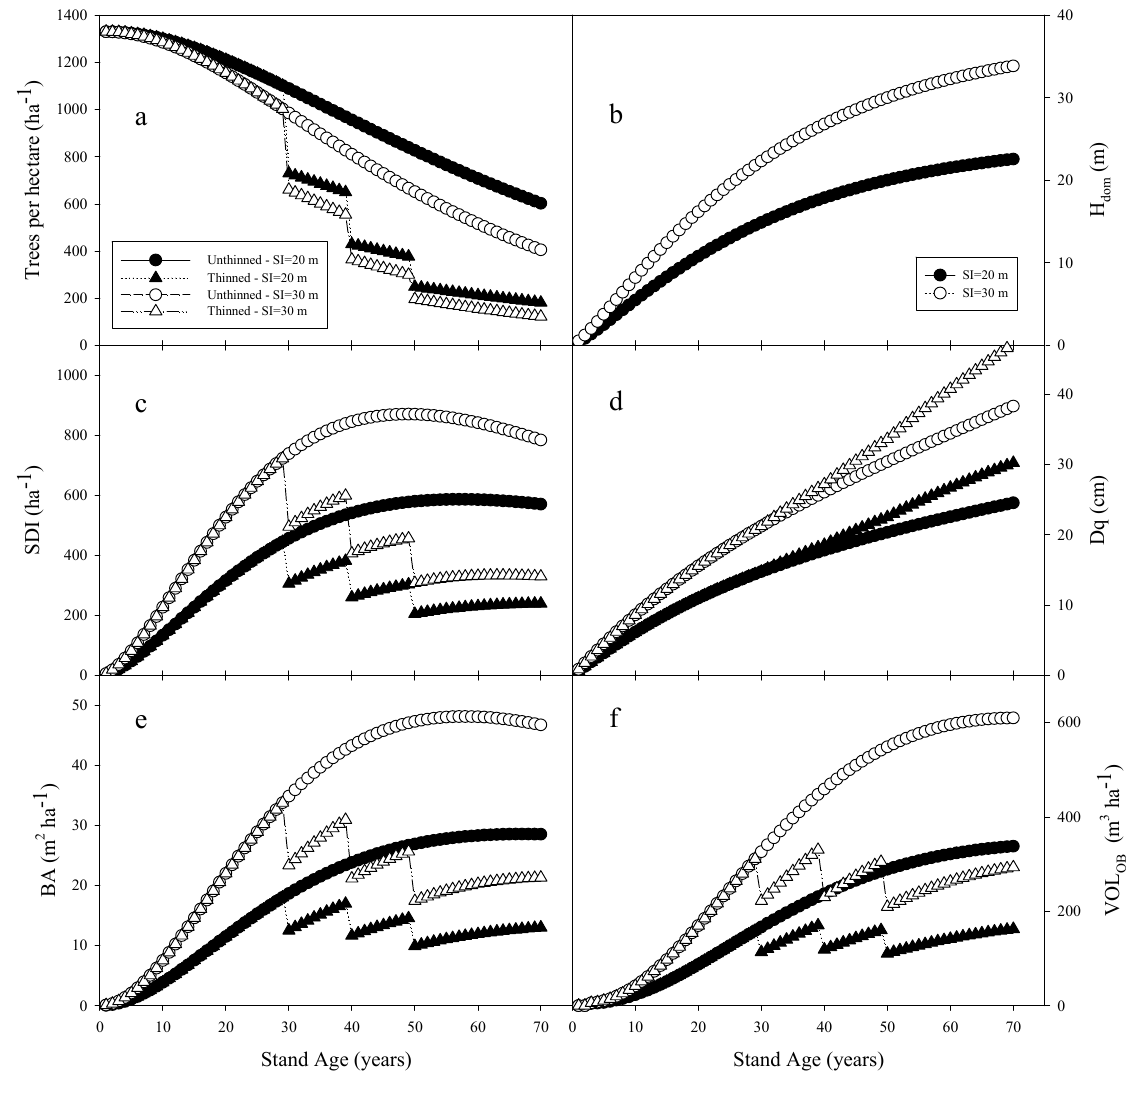
Figure 7. Example of model outputs. Simulation of survival (N, trees ha − 1 ): ( a ) dominant , m); ( b ) stand density index (SDI, trees ha − 1 ); ( c ) quadratic mean diameter height (H dom (Dq, cm); ( d ) basal area (BA, m 2 ·ha − 1 ); ( e ) and stem volume outside bark (VOL m 3 ·ha − 1 ); ( f ) of unthinned (circle) and thinned (triangle) longleaf pine stands growing in sites with two different SI (20 m: black filled; 30 m: white